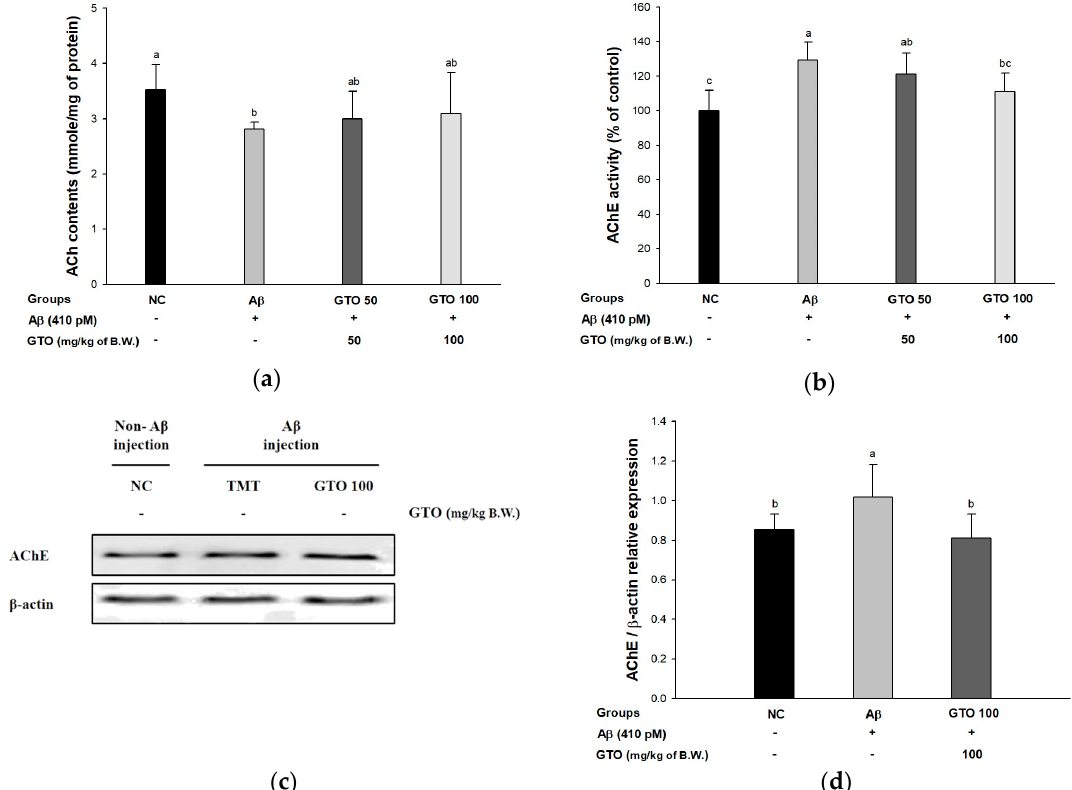
Figure 6. Protective effect of green tea seed oil (GOT) on A β -induced cholinergic dysfunction. ( a ) ACh levels; ( b ) AChE activities; ( c ) protein expression levels; ( d ) representative Western blots for total protein and expression of AChE in mice brain tissues. Results shown are mean ± SD ( n = 8). Data were statistically represented at p < 0.05, and different lowercase letters indicate statistical significance. NC: A β − /sample − group; A β : A β + /sample − group; GTO 50: A β + /GTO (50 mg/kg of body weight) + group; GTO 100: A β + /GTO (100 mg/kg of body weight) + group. B.W.: body weight. Table 3. Protective e ff ect of green tea seed oil (GOT) on A β -induced mitochondrial dysfunction. Parameters